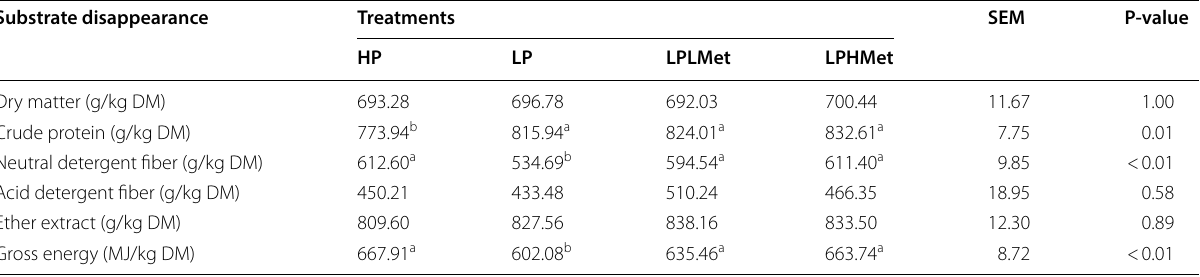
SEM, standard error of mean a,b Superscripts values within the same row, are significantly different at (P < 0.05) Table 4 Addition of RPMet with low CP their effects on daily production of total and individual volatile fatty acids using the RUSITEC (n 4) =